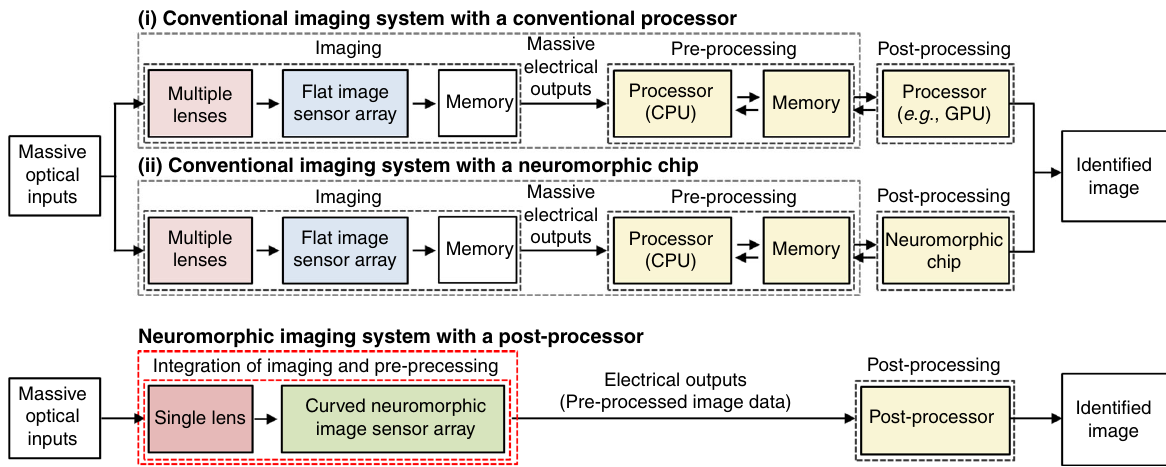
Fig. 1 Curved neuromorphic imaging device inspired by the human visual recognition system. a Schematic illustration of the human visual recognition system comprised of a single human-eye lens, a hemispherical retina, optic nerves, and a neural network in visual cortex. The inset schematic shows the synaptic plasticity (i.e., STP and LTP) of the neural network. b Schematic illustration of the curved neuromorphic imaging device. The inset in the dashed box shows the concept of photon-triggered synaptic plasticity that derives a weighted electrical output from massive optical inputs. c Block diagram showing the sequence of the image recognition using the conventional imaging and data processing system (e.g., conventional imaging system with a conventional processor (top) or with a neuromorphic chip (bottom)). d Block diagram showing the sequence of the image recognition using cNISA and a post-processor (e.g., GPU or neuromorphic